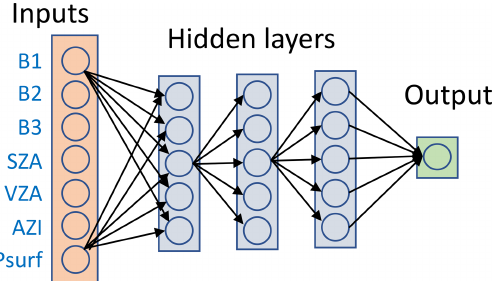
Figure 1. Graphical representation of the NN used in this paper. The outputs from all neurons feed in all neurons of the next layer. There is a variable number of hidden layers. Similarly, there is a choice of the number of neurons in each layer. Not all inputs are used for the various versions of the NN that are described in this